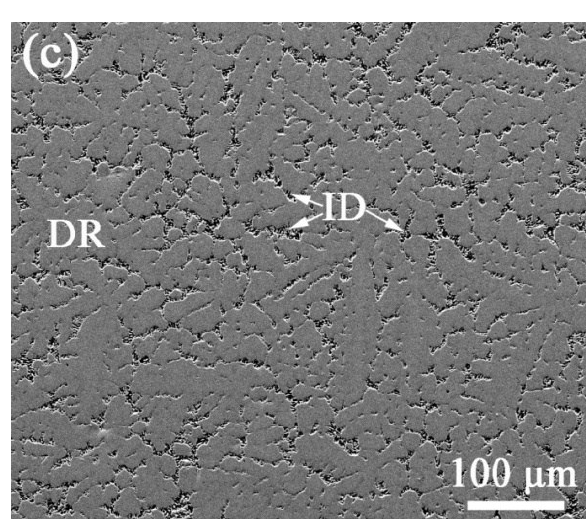
Table 1. Chemical mixing enthalpy (